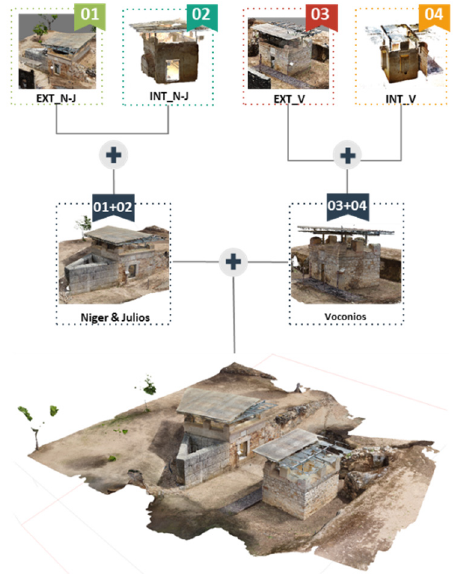
Figure 11. Scheme of the work process followed, from obtaining the partial point clouds to obtaining a single complete point cloud. It can be seen that the fusion of the different blocks was carried out in several stages.